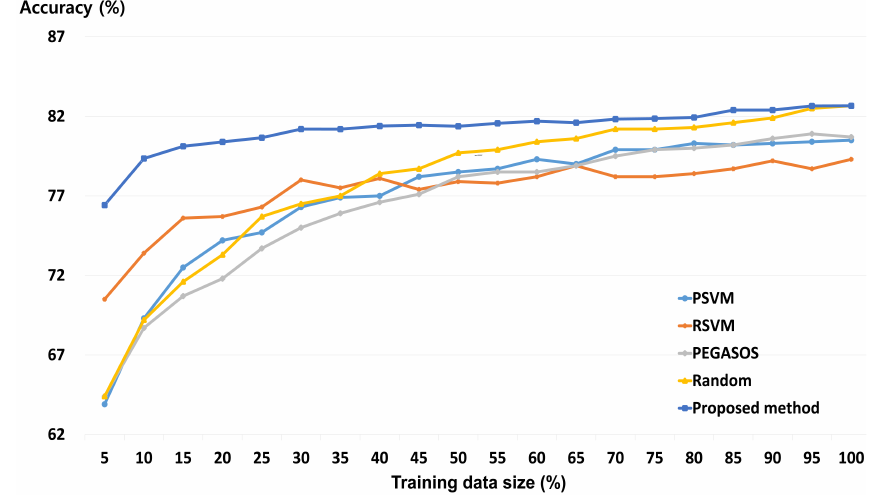
Figure 5. Mean classification accuracy based on selected training data on all